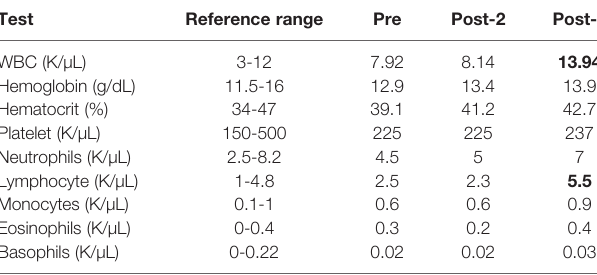
TABLE 1 | Complete blood count with differentials.